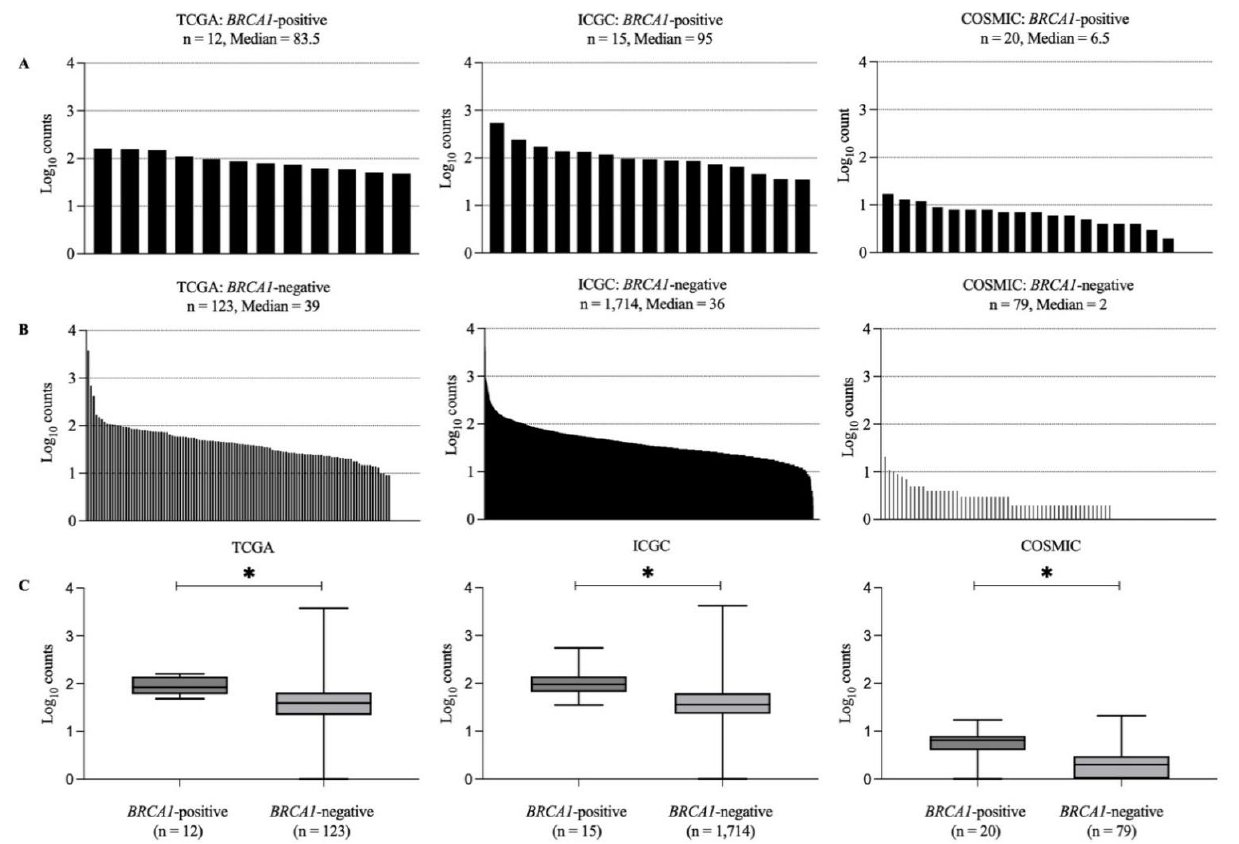
Figure 4. Total count of non-synonymous variants per sample of ( A ) BRCA1 -positive and ( B ) BRCA1 - negative breast cancer samples. Comparison of total count of non-synonymous variant per sample between BRCA1 -positive and -negative within the same database using Mann – Whitney U test ( C ). The box plot showed median, the lower quartile, and the upper quartile. * Indicates p < 0.05. The y -axis represents log 10 (variant counts of each sample). The number of samples is indicated below the box plot ( n ).